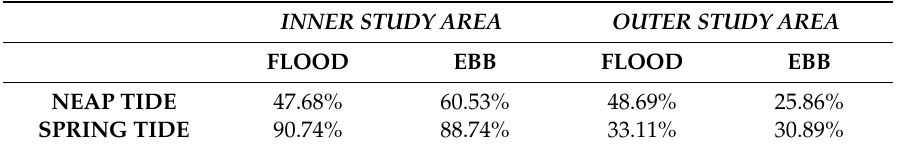
Table 3. Percentage of Qb covered by Sb (availability of sediments) for complete tidal current